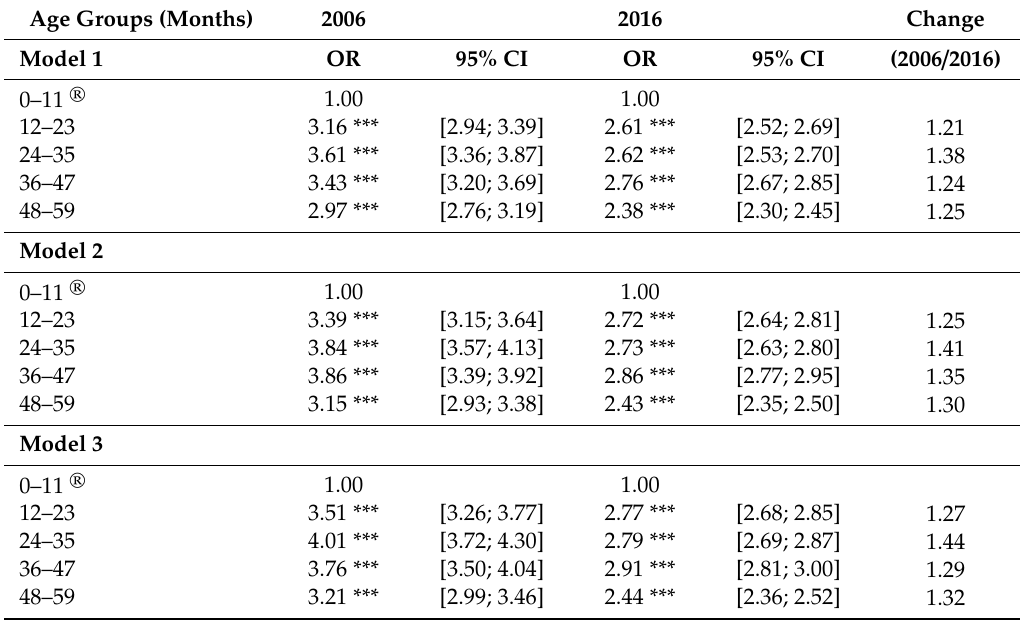
Table 3. Econometric association between child stunting and age groups, India, NFHS 2006, and